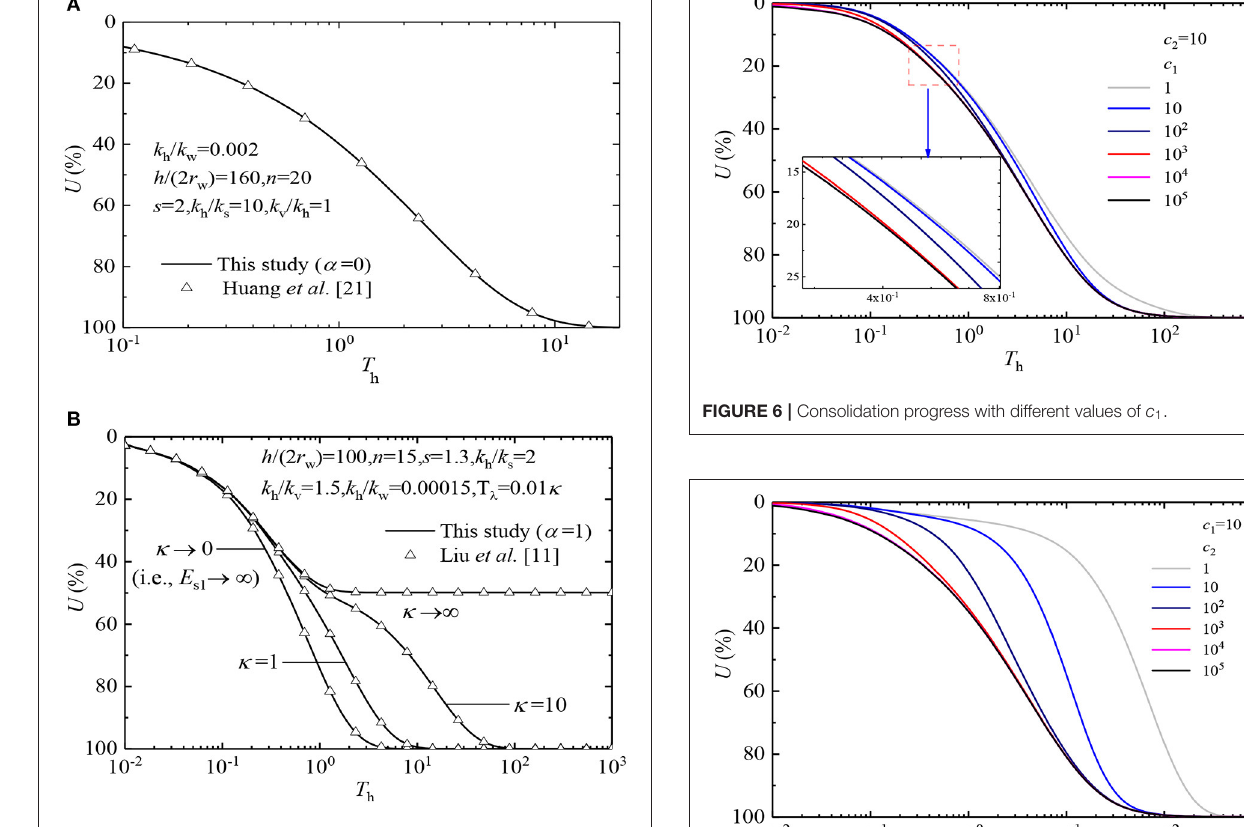
FIGURE 4 | Results of the comparison of U -curve: (A) degeneration to the Terzaghi drainage boundary; (B) degeneration to the SM model.